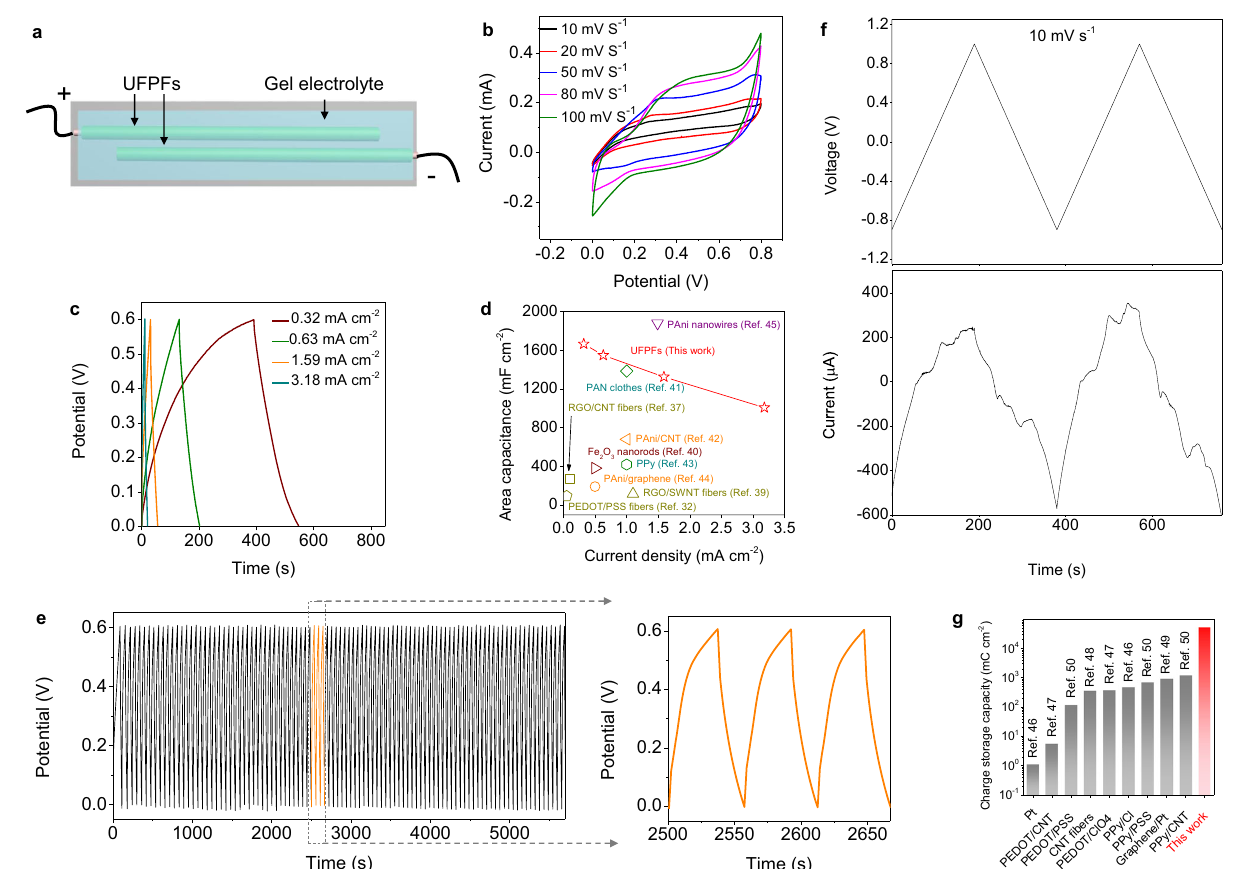
Fig. 3 Energy and charge storage capacities of UFPFs. a Schematic of a micro capacitor constructed using two UFPF electrodes on a substrate. b Cyclic voltammetry curves with the increasing scan rates from 10 to 20, 50, 80, and 100 mV s − 1 . c Galvanostatic charge/discharge curves at various current densities increasing from 0.32 to 0.63, 1.59, and 3.18 mA cm − 2 . d The area capacitance of UFPFs compared to previously reported electrodes. e Cycle galvanostatic charge/discharge curves during 120 cycles between 0 and 0.6 V at 1.59 mA cm − 2 . f The relationship between current and voltage at a slow rate of 10 mV s − 1 . g The charge storage capacity of UFPFs comparing to other charge storage